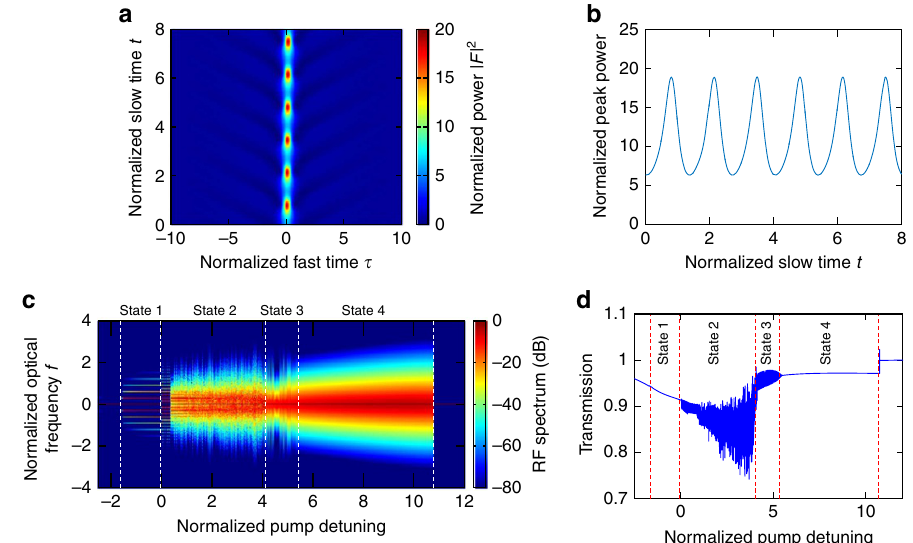
Figure 1 | Numerical simulation of breather solitons. ( a ) The temporal evolution of a breathing temporal cavity soliton (CS). The period of the breathing cycle is 1.34 normalized slow time units. ( b ) The corresponding temporal evolution of the CS peak power. ( c ) Simulated density plot of instantaneous optical spectra as a function of the normalized absolute pump detuning D (from (cid:2) 2.9 to 12) and ( d ) the corresponding resonator transmission. The vertical dashed lines in c , d indicate the four different regions that correspond to (i) the primary comb state, (ii) unstable MI state, (iii) breather soliton state and (iv) stable soliton state. All the values are dimensionless (details in Methods). NATURE COMMUNICATIONS|8:14569|DOI: